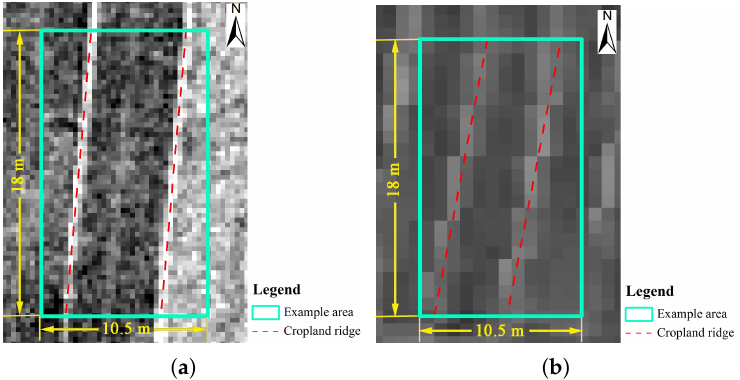
Figure 2. Limited performance of satellite panchromatic image in cropland ridge identification: ( a ) WorldView-3 (0.31 m), ( b ) GF-2 (0.81 m). The bigger the digital number, the brighter the image